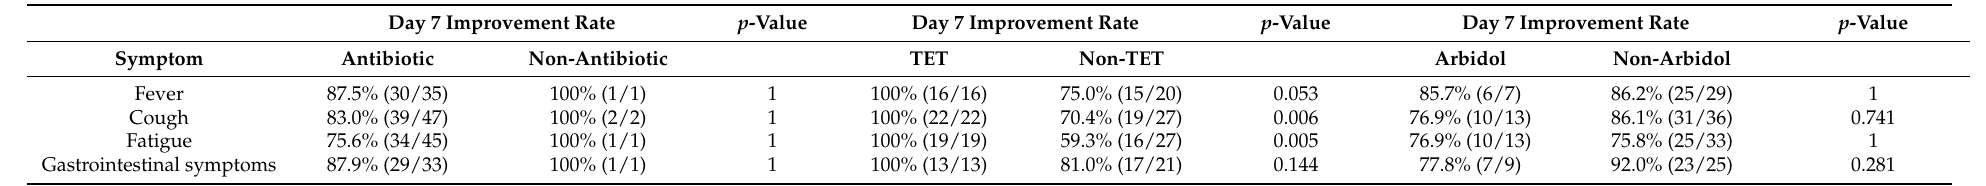
Table 5. Improvement of clinical symptoms in moderate COVID-19 patients with and without antibiotic, tetrandrine and